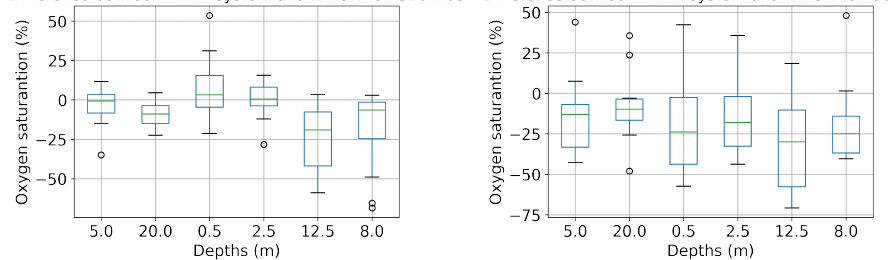
Figure 20. Comparison of FL dissolved oxygen saturation between AHFM time series and manual sampling with IDRONAUT